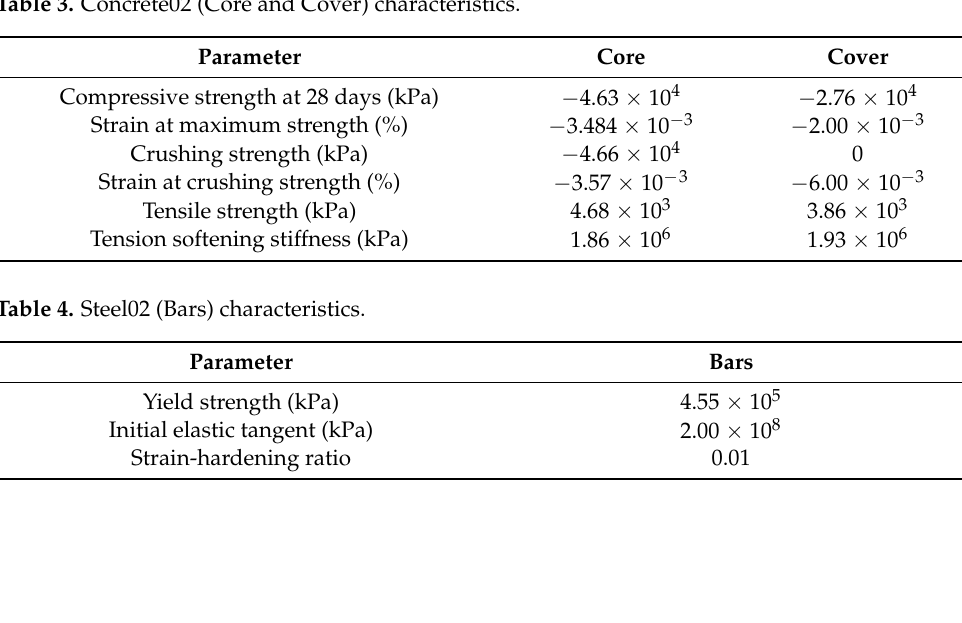
Table 3. Concrete02 (Core and Cover) characteristics.